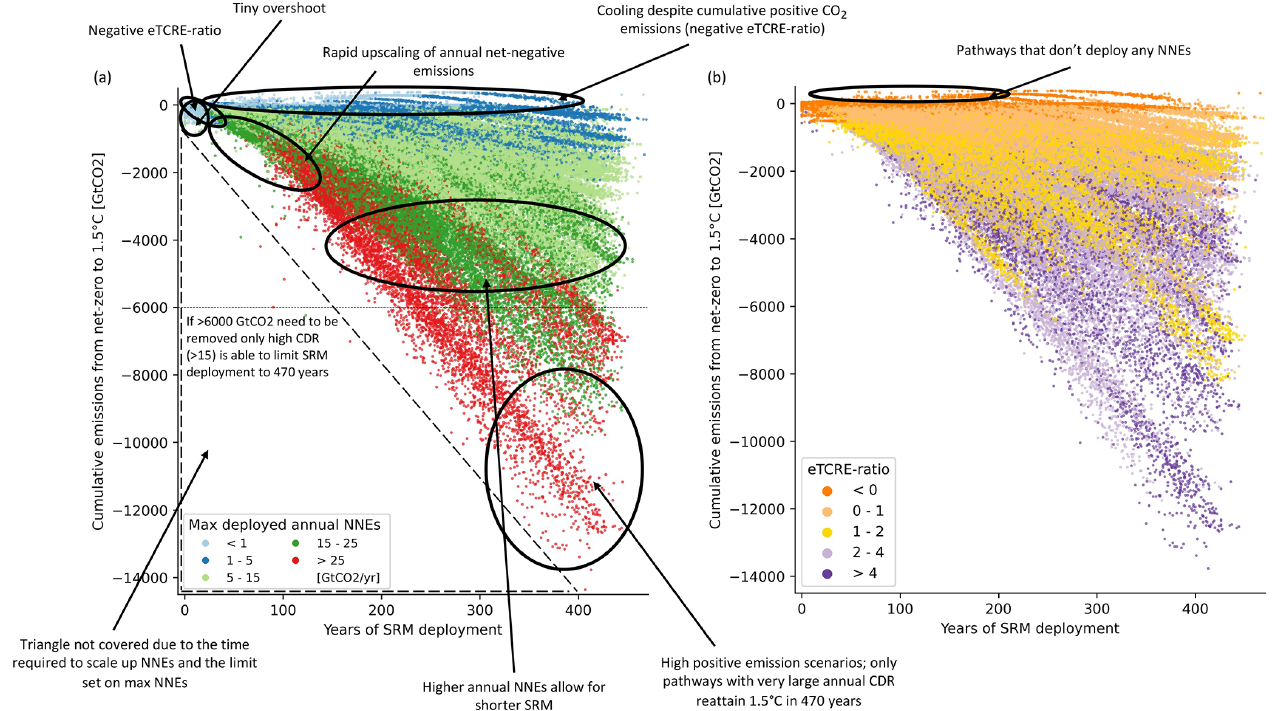
Figure 5. Relationship between cumulative CO 2 emissions from net-zero CO 2 until the reattainment of 1.5 ◦ C and SRM deployment length. (a) Colour coding is according to the maximum deployed annual NNEs. (b) Colour coding is according to the eTCRE ratio. See the clean figure without descriptions in the Supplement (Fig.